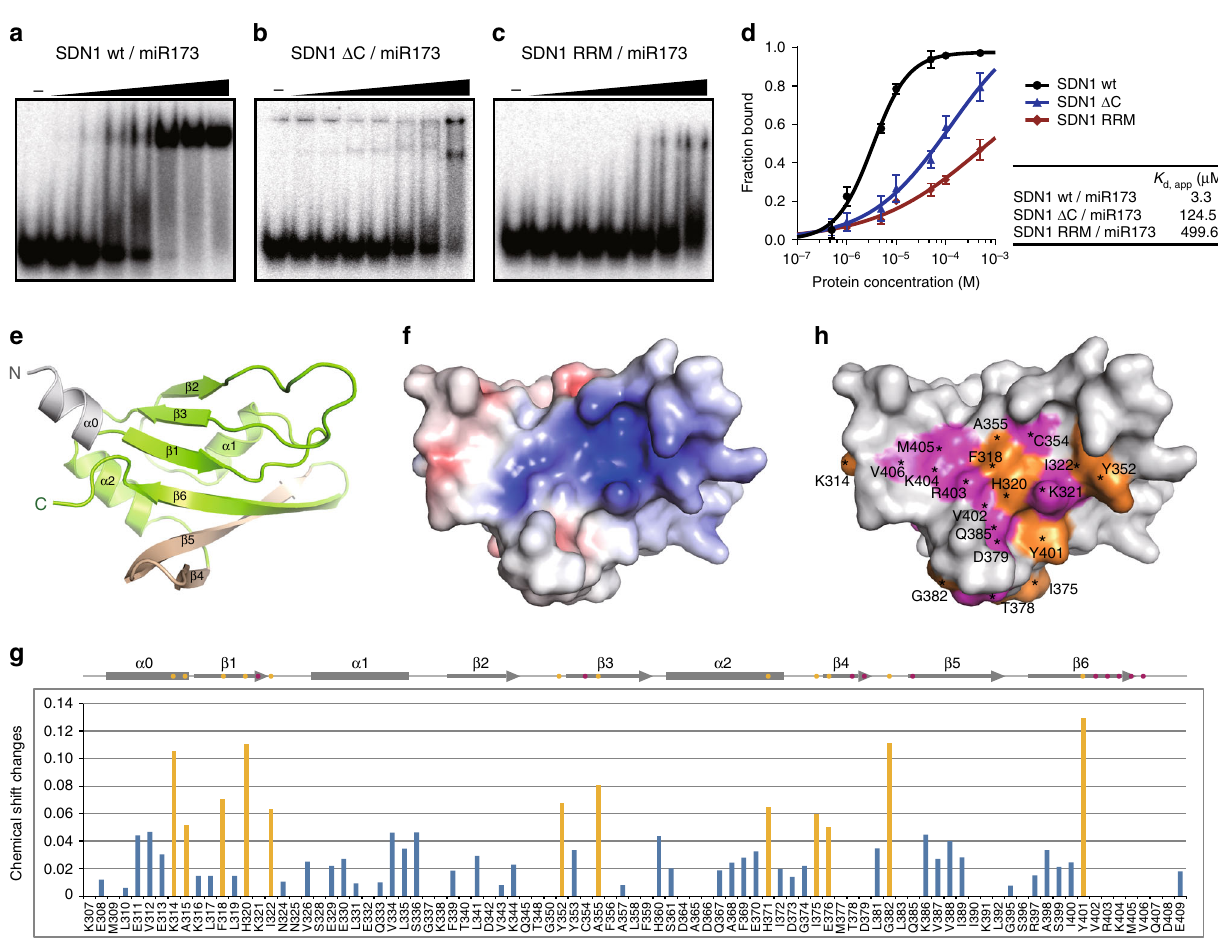
Fig. 3 Structure and RNA binding properties of the SDN1 CTD RRM domain. a – c Electrophoretic mobility shift assays (EMSA) of wild-type SDN1 ( a ), SDN1 Δ C ( b ) and SDN1 RRM ( c ) with 32 P-labeled miR173. Assays were conducted at a series of protein concentrations: 0.5 µ M, 1 µ M, 5 µ M, 10 µ M, 50 µ M, 100 µ M, and 500 µ M (from left to right). No Mg 2 + was included to prevent catalytic activity. Scale bars represent standard deviations calculated from three biological replicates. d Plots showing the fraction of the protein-bound RNA at varying protein concentrations. The fraction of bound RNA was calculated from the densities of the free RNA bands in a , b and c . e Crystal structure of the SDN1 CTD E329A/E330A/E332A mutant. The N-terminal, fi rst α helix connecting the RRM domain is colored in gray; the extended β 4 and β 5 in the RRM domain are shown in yellow. f Surface electrostatic potential of the SDN1 RRM domain showing that the antiparallel β sheet forms a positively charged surface. Red, − 5.0 k B T / e ; Blue, + 5.0 k B T / e . g Changes in chemical shifts for cross-peaks in the RRM spectra during NMR titration. Residues that show large chemical shift perturbations ( Δδ avg > 0.05 ppm) are colored in orange and indicated in orange dots in the diagram above. Residues of which cross peaks disappeared are indicated in pink dots in the diagram above. h The molecular surface of SDN1 RRM, onto which the above residues were mapped. This reveals that the antiparallel β sheet surface is responsible for RNA substrate binding. Residues that show large chemical shift changes or for which signals disappeared during titration are colored in orange or pink,